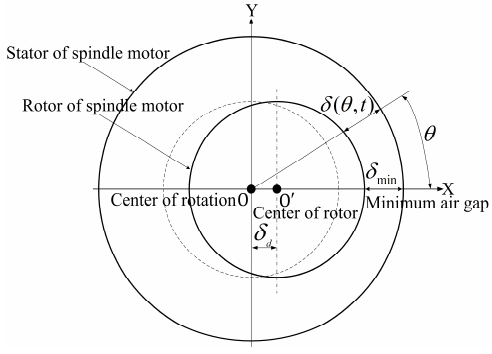
Figure 2. Schematic diagram of dynamic air gap unbalance for the motor of a motorized spindle.